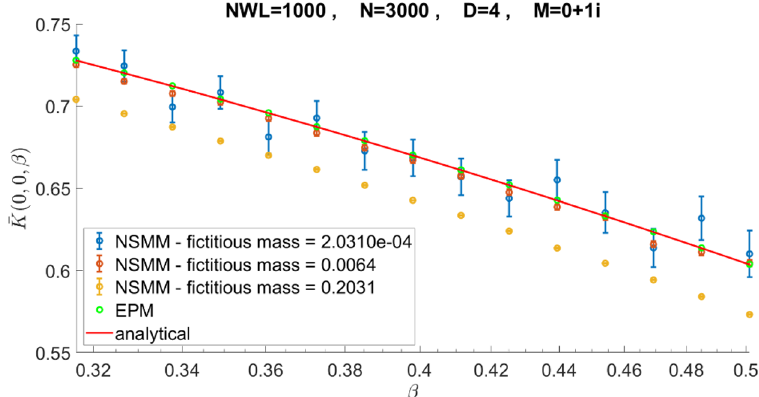
Figure 10 . Calculations of the heat kernel for the free scalar particle on a hyperboloid with D = 4 and | M | = 1 , for a window of β -values. The plot shows the comparison of the calculation when different values of α are implemented, in particular α min = 0 . 0064 , α − = 0 . 0002 and α + = 0 . 2031